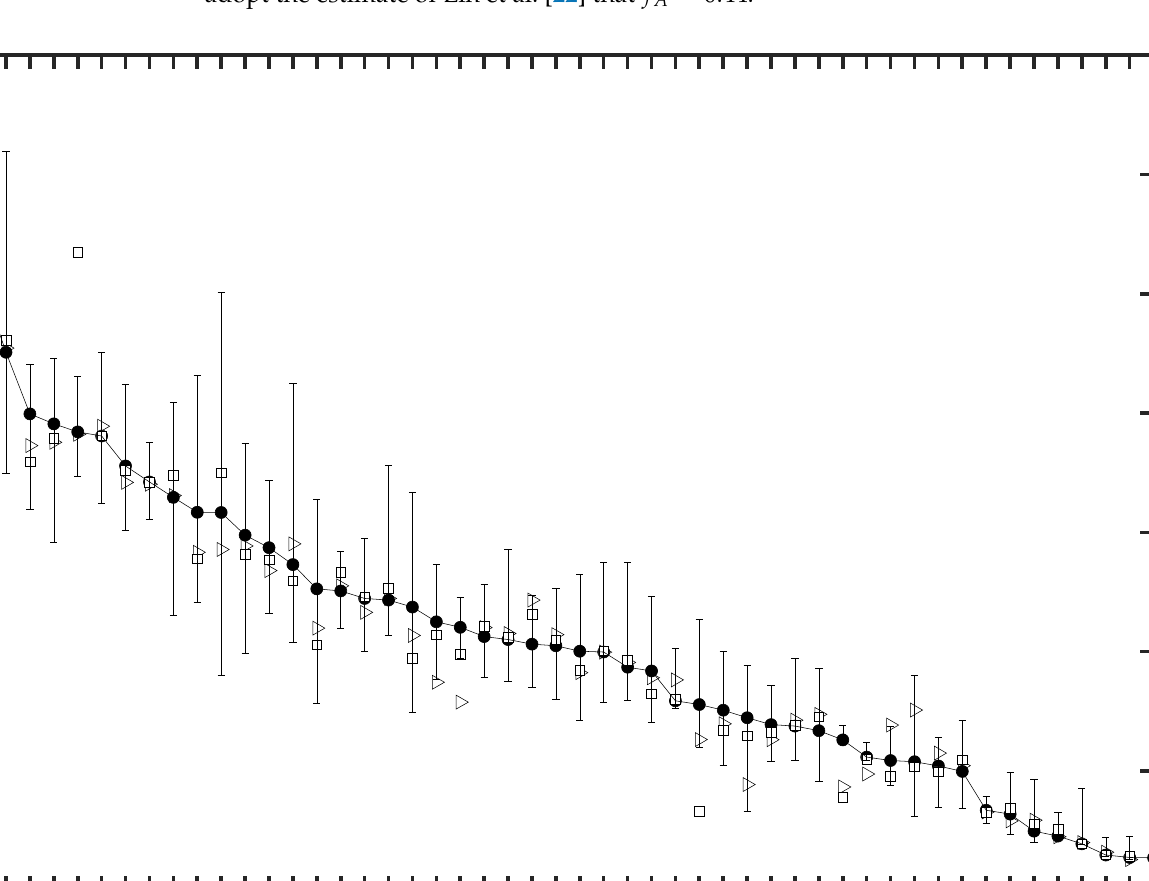
Figure 5. MAP estimates of the basic reproduction number R 0 for ancestral strains of SARS-CoV-2 in all 50 US states. The different symbols refer to different training datasets used to estimate R 0 . Open triangles correspond to surveillance data collected from 21 January to 21 May 2020, filled circles correspond to surveillance data collected from 21 January to 21 June 2020, and open squares correspond to surveillance data collected from 21 January to 21 July 2020. Estimates of R 0 are sorted by state from largest to smallest values according to the R 0 estimates derived from the surveillance data collected for 21 January to 21 June 2020. The whiskers associated with each filled circle indicate the 95% credible interval (inferred from the 5-month dataset). States are indicated using two-letter US postal service state abbreviations (https://about.usps.com/who-we-are/postal-history/state-abbreviations.pdf (accessed on 19 September 2021 )).